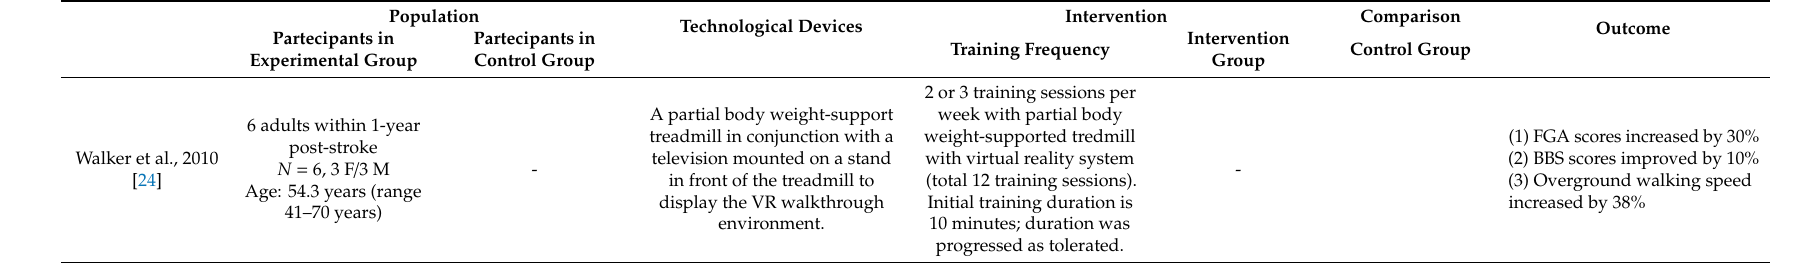
Table 2. Descriptive analysis of the included clinical